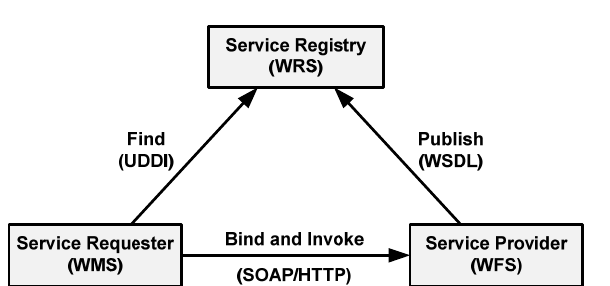
Fig. 2. GIS Web services representation with 3 major